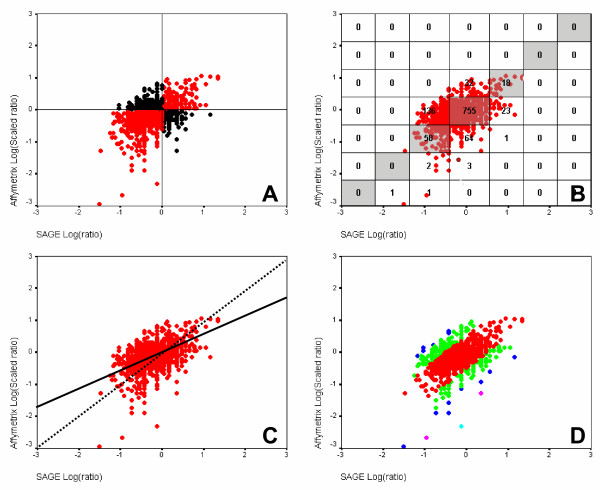
Comparison of SAGE and Affymetrix HG-U133A GeneChips results using the scaled ratios between Wilms' tumor and Stratagene Universal Reference RNA expression levels. A: Up/Down classification. The red points in the upper-right and lower-left were considered to be in agreement between the platforms. B: contingency table diagonal based on the classification of gene expression ratios into log (10-fold) classes. The genes falling in the classes on the diagonal were considered to be in agreement between the platforms. C: Pearson correlation coefficient. The correlation coefficient was 0.472 and corresponds to a linear regression line with a slope of 0.492 (solid line) The Y = X line with a slope of 1 (dashed line) is the expected line when both platforms have identical expression patterns. D: absolute between-platform ratio differences (see Figure 4) were calculated and classified: 0–0.5 (red), 0.5–1.0 (green), 1.0–1.5 (blue), 1.5–2.0 (magenta), 2.0–2.5 (light blue). These classes represent an approximate less then 3, 10, 30, 100, and 300-fold difference, respectively, between the two platforms. The points in the 0.5 zone were considered to be in agreement between the platforms.